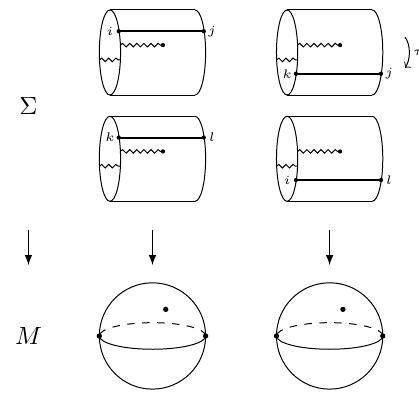
Figure 10 . Evolution under the open string modular Hamiltonian is represented as cylindrical worldsheets where time runs transverse to branch cuts. The (cid:12)gure shows a pair of open strings and their Chan-Paton indices at two di(cid:11)erent time slices. The indices on the left endpoints are exchanged as they pass through the branch